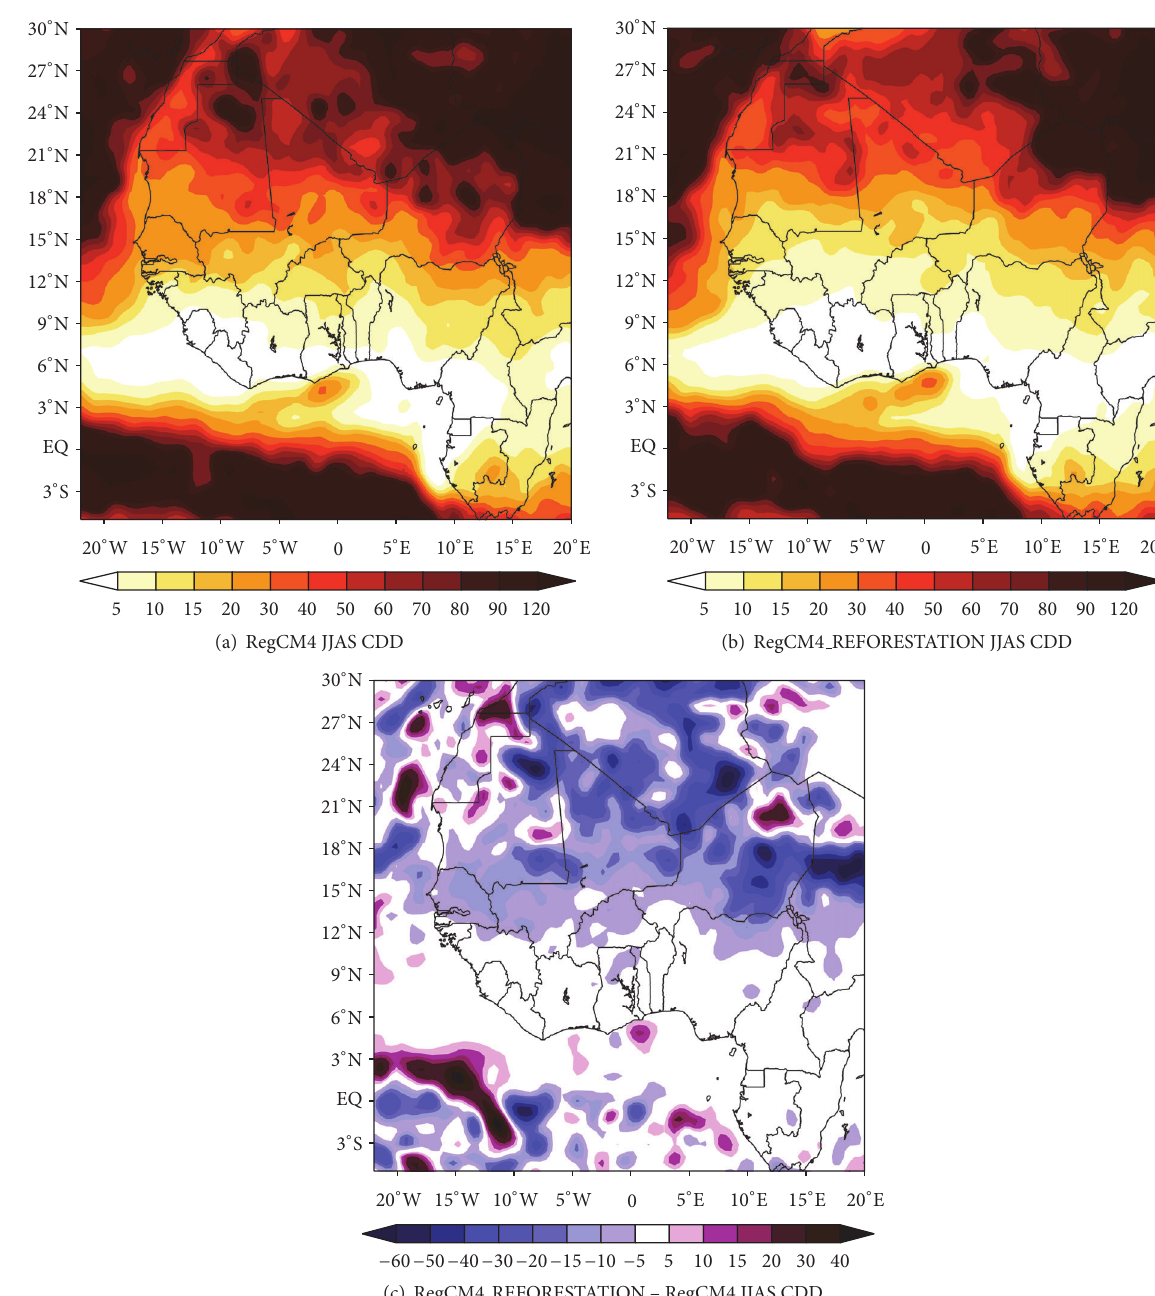
Figure 16: Maximum length of the consecutive dry days (CDD) for both runs and their difference averaged from 2003 to 2009.